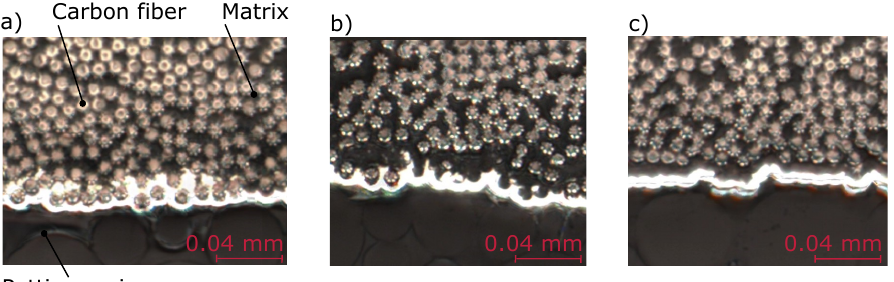
Figure 11. Cross section pictures showing ( a ) a well bonded electrodeposition of nickel after etch treatment, ( b ) a delaminated layer of nickel after etch treatment which was likely caused during specimen cutting, ( c ) a poorly deposited layer of nickel due to insufficient surface